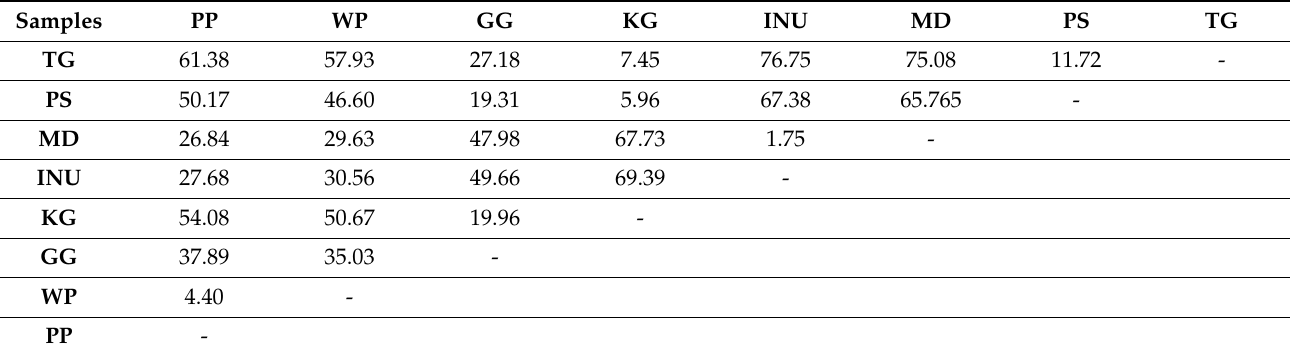
Table 3. The color difference parameter ( ∆ E) between the analyzed biopolymers (values are mean; n = 3).